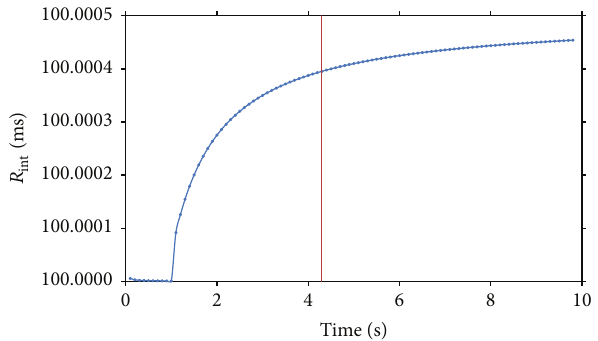
Figure 13: Resynchronization interval as obtained in the slave. Linearly increasing